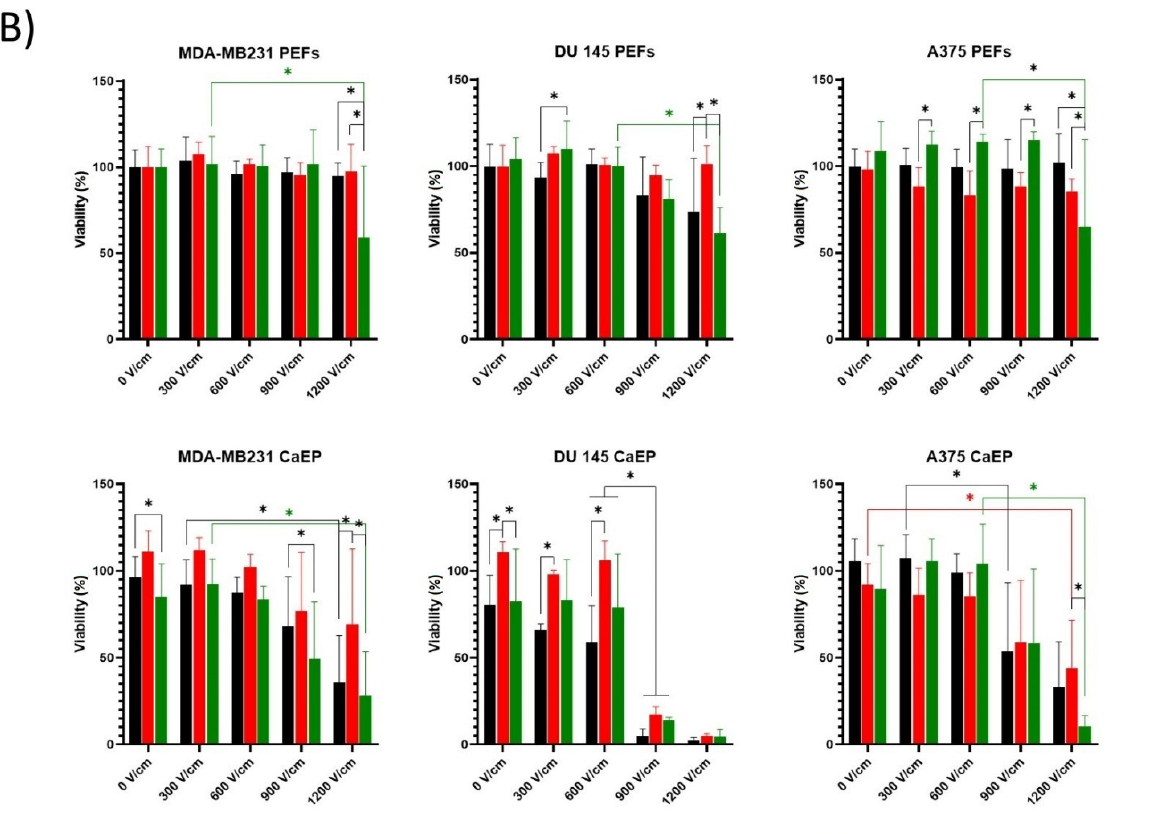
Figure 6. MTT assay. Cells’ viability expressed by the mitochondrial activity of the cells measured. ( A ) 48 h after PEF with and without 5 mM calcium ions on MDA-MB231, DU 145, and A375 cell lines. Data presented as mean ± SD (21 > n > 6); ( B ) 120 h after PEF with and without 5 mM calcium ions on MDA-MB231, DU 145, and A375 cell lines. Data presented as mean ± SD, (17 > n > 6). Black line: cells without atorvastatin; red line: cells preincubated with 50 nM atorvastatin for 48 h before PEF treatment (long-term effects); green line: the cells which were treated with 50 nM atorvastatin directly in the electroporation buffer (short-term effects—without 48 h preincubation time). ANOVA analysis * p <